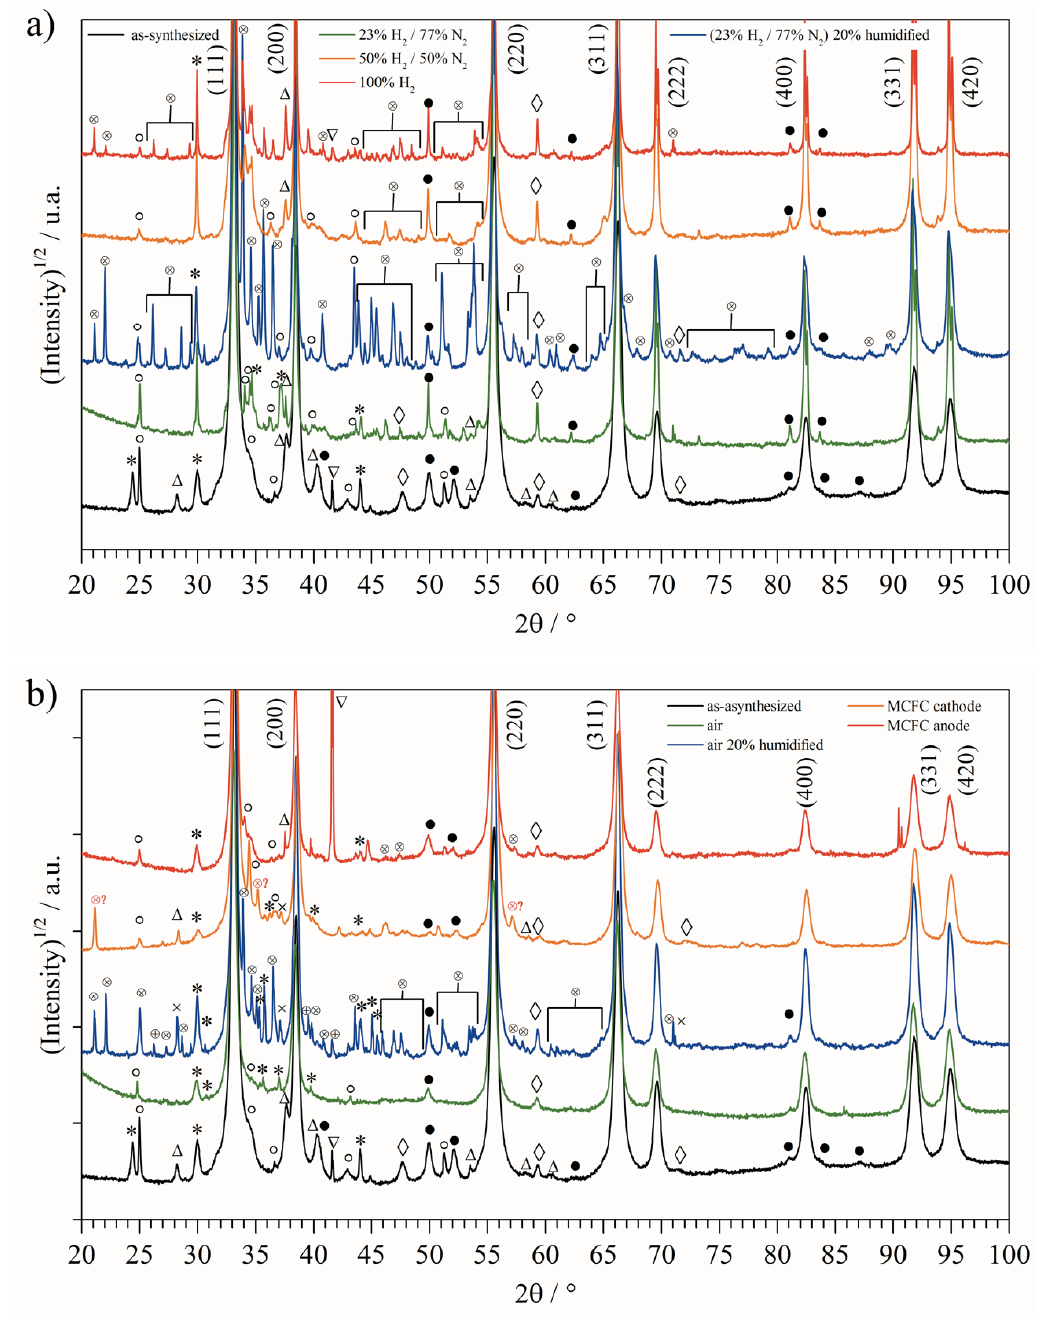
Figure 8. ( a )—X-ray diffraction patterns of SDC—LiNaK electrolyte after operation in reducing atmospheres: dry or wet, different content of H 2 diluted in N 2 (from 23 to 100 %vol). ( b )—X-ray